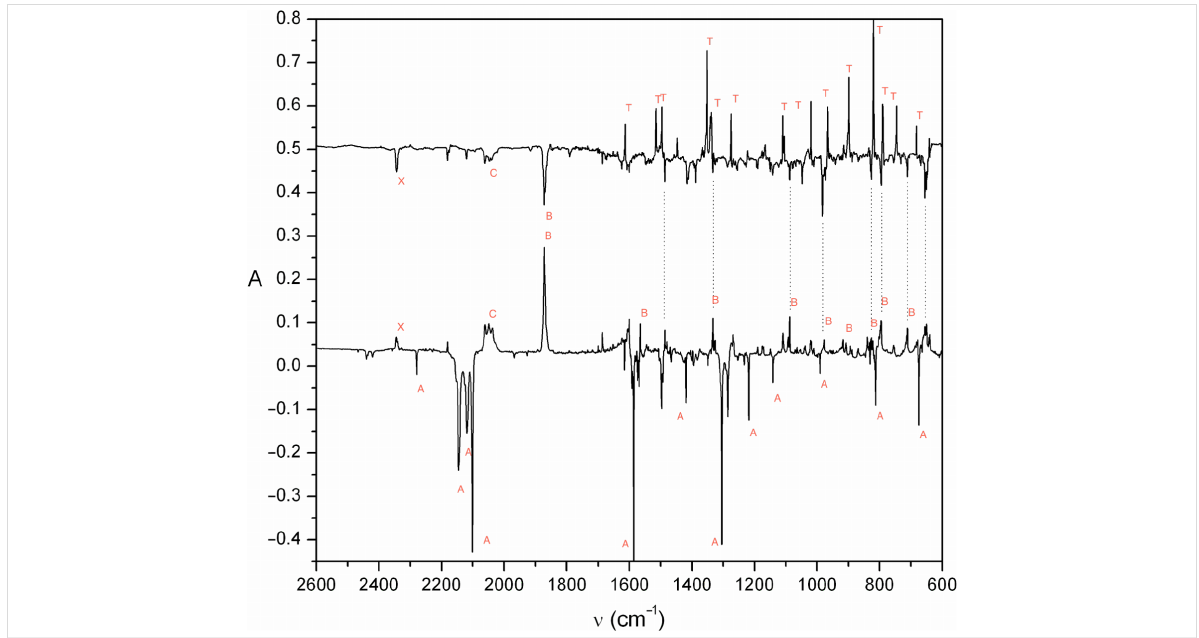
Figure 2: Ar matrix IR-difference spectra showing the products of broadband UV photolysis of 4-azidopyridine ( 18 ) (bottom, bands labelled A) and 1,2,3-triazolo[1,5- a ]pyrazine ( 24 ) (top, bands labelled T). In the photolysis of 18 the negative peaks (A) are due to the subtracted spectrum of azide 18 ; the positive peaks are due to the products 20 (B) and 27 (C). In the photolysis of 24 the negative peaks are the products 20 and 27 ; the positive peaks are due to the subtracted spectrum of the triazole 24 (T). A small peak labelled X at 2340 cm − 1 is due to CO 2 . Ordinate in arbitrary absorbance units. See Figure S1–S3 in Supporting Information File 1 for full spectra of 18 , 20 and 24 with peak listings.